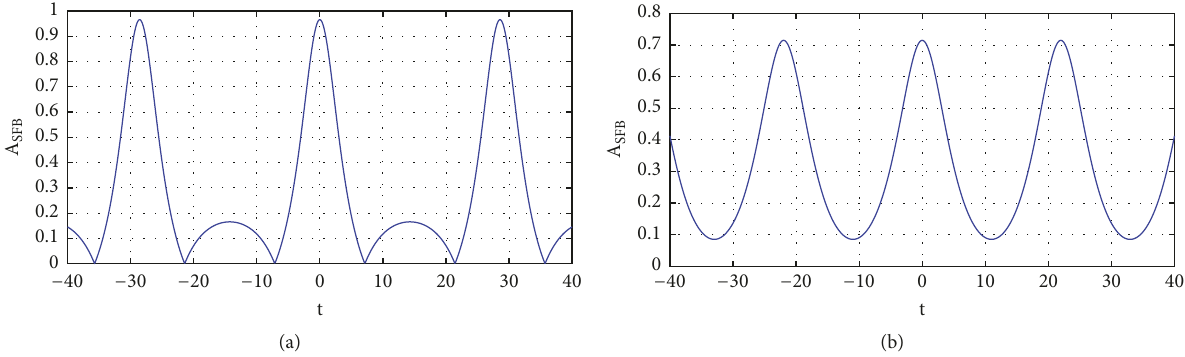
(𝑥,𝑡)| at 𝑥 = 0 for ̂ ] = 1 . (b) Curve of envelope |𝐴 Figure 5: (a) Curve of envelope |𝐴 SFB wave dislocation when the waves split into two waves and merge into one wave near (before and after) the wave